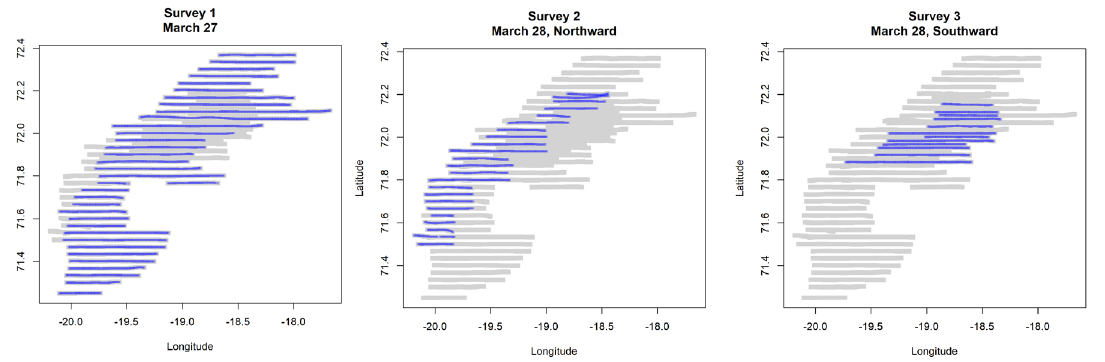
Figure 5. Maps showing the distribution of photographs designated to the three surveys (blue), overlaid on all surveys combined (grey). Table 2. Uncorrected pup production estimates for separate surveys. Survey 1: March 27, Survey 2: March 28, northward, Survey 3: March 28 southward. Species Survey Count N SE lowerCI upperCI Harp Harp